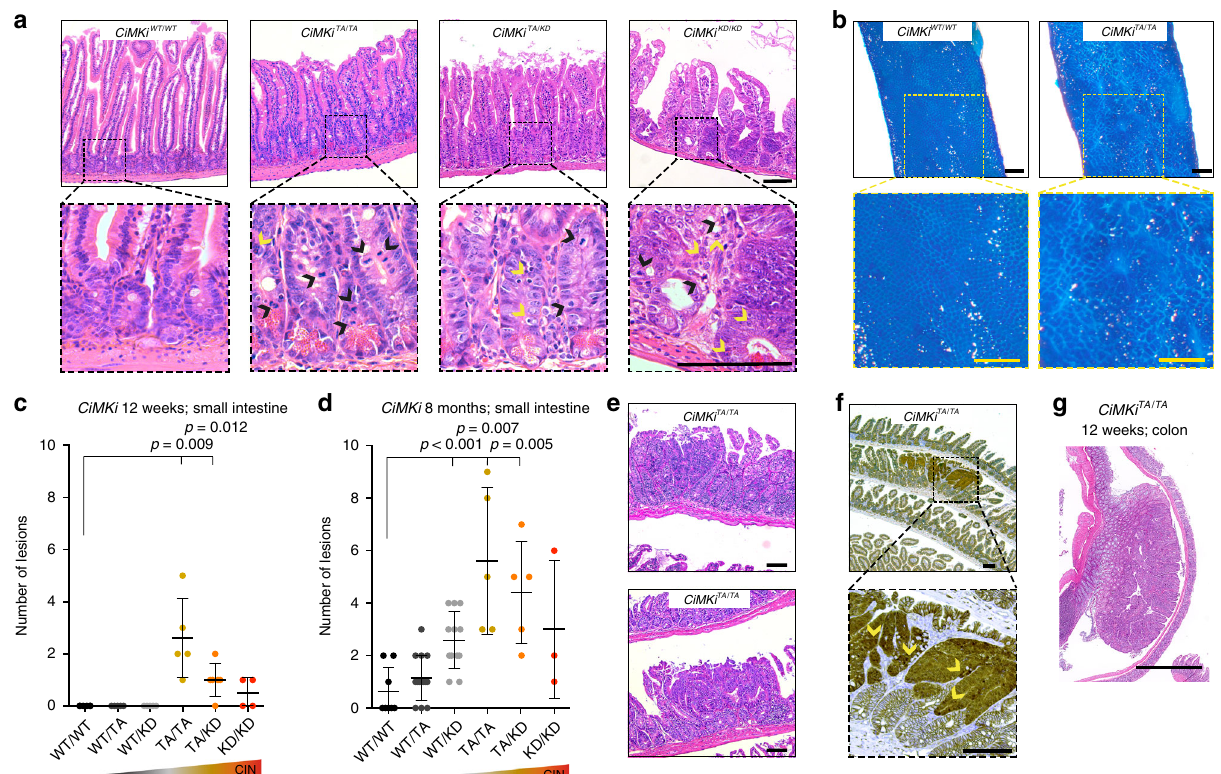
Fig. 2 Moderate CIN causes early onset spontaneous tumor initiation in the intestine. a H&E of CiMKi;Rosa26-CreER T2 small intestines one week after tamoxifen injection, showing aberrant crypt and cell size, hyperproliferation (black arrowheads indicate mitotic cells) and apoptotic bodies in crypt (yellow arrowheads), scale bars 100 μ m. b Methylene blue stained, formalin- fi xed whole mount small intestine of 12-week old CiMKi;Villin-Cre mice. Zoom boxes indicate normal ( CiMKi WT/WT ) and aberrant ( CiMKi TA/TA ) mucosa. Scale bars 1 mm. c Quanti fi cation of adenomas as determined on whole mount methylene blue staining in small intestine tissue in of 12-week-old CiMKi;Villin-Cre mice. Data represents mean ± SD, ( n = 6 (WT/WT), 5 (WT/TA), 5 (WT/KD), 5 (TA/TA), 6 (TA/KD), or 4 (KD/KD) mice per genotype. d Quanti fi cation of adenomas as in c , but for small intestines of 8-month-old CiMKi; Villin-Cre mice ( n = 8 (WT/WT), 14 (WT/TA), 12 (WT/KD), 5 (TA/TA), 5 (TA/KD), or 3 (KD/KD) mice per genotype. e H&E of small intestine adenomas from 12-week old CiMKi TA/TA ;Villin-Cre mice (moderate CIN), scale bars 100 μ m. f ß-catenin immunohistochemistry on small intestine lesions in 12-week old CiMKi TA/TA ;Villin-Cre mice. Arrowheads indicate nuclear ß-catenin, scale bars 100 μ m. g H&E staining of low-grade colon adenoma from a 12-week old CiMKi TA/TA ;Villin-Cre mice (moderate CIN). Scale bar 1 mm. Statistics for panels c and d : one-tailed Welch ’ s t -test, comparing each group to CiMKi WT/WT ; Villin-Cre , exact p -values are indicated when p < 0.05. Source data for panels c and d are provided as a Source Data fi